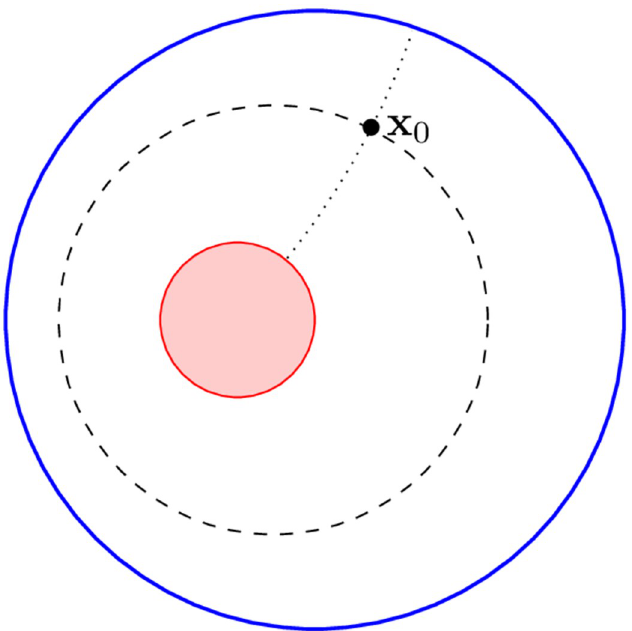
Fig 1. The domain is the interior of the unit circle (blue) with a circular inclusion (red). The initial position of a diffusing particle, x 0 , has bipolar coordinates τ 0 , σ 0 . The dashed circle is the set of points with τ = τ 0 . The dotted arc is part of the set of points with σ = σ 0 . G 1 ( x 0 , x ) is the solution of (4), constrained to be zero on the unit circle and to have normal derivative on the inclusion. G 2 ( x 0 , x ) is the solution of (4), constrained to be zero on the inclusion and to have normal derivative on the unit